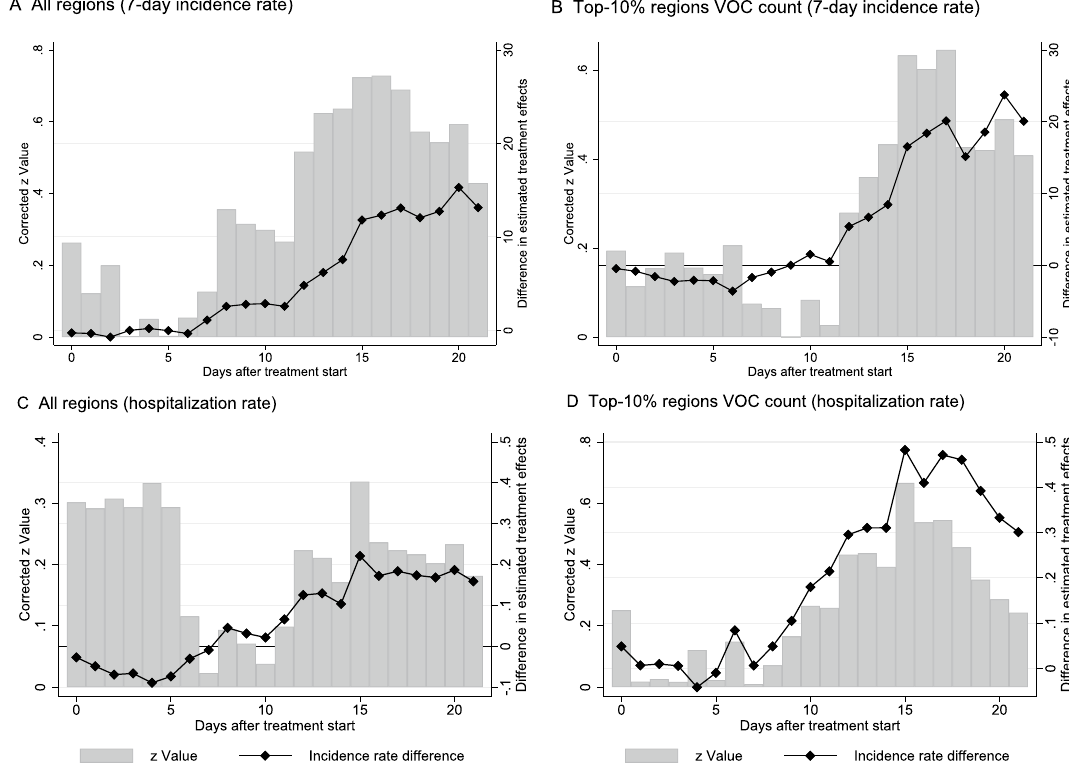
Figure 6. Difference in estimated daily PES coefficients and statistical tests for coefficient equality across models. The time-series plot in Panel ( A ) shows the development in the coefficient difference for the dynamic β original β reweighted effect of VOC reporting on the 7-day incidence rate as , where β original are the daily − PES coefficients from Panel A of Fig. 3 and β reweighted are the corresponding re-estimated coefficients using (cid:31) (cid:30) post-sampling ratio weights. Both specifications follow the estimation setup described in the footnote of Fig. 3 and Panel A plots coefficient differences for lags (20) around the start of the first VOC reporting in a treated regions. Bars report the z Values obtained from a z -test of coefficient equality across specification as described in the notes of Table 3. Panels ( B ) shows coefficient differences for the effect on the 7-day incidence rate and corresponding z Values for the subsample of treated regions belonging to the top 10% in terms of VOC count. Panels ( C , D ) report the corresponding overall and subsample results for the hospitalization rate (all patients in intensive